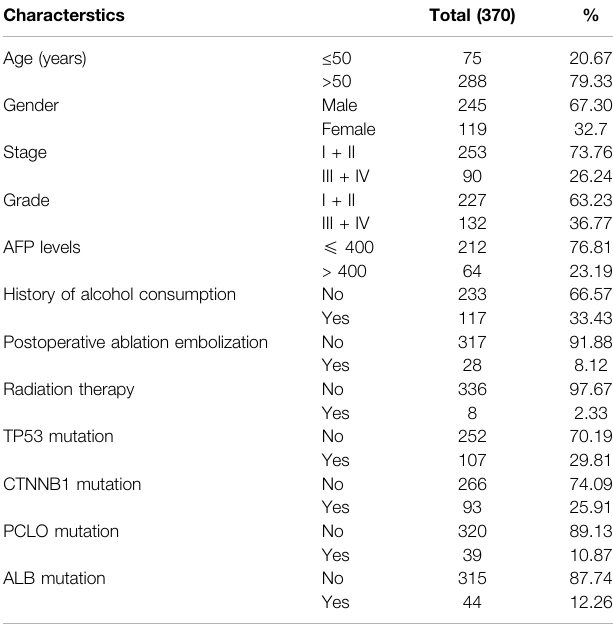
TABLE 1 | Patient charcterstics in TCGA-LIHC